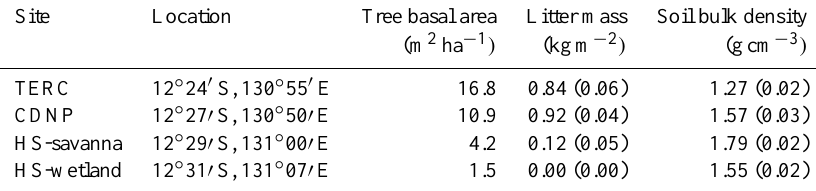
Table 1. Site characteristics including location, tree basal area, litter mass, and soil bulk density; standard errors of the mean in parentheses.